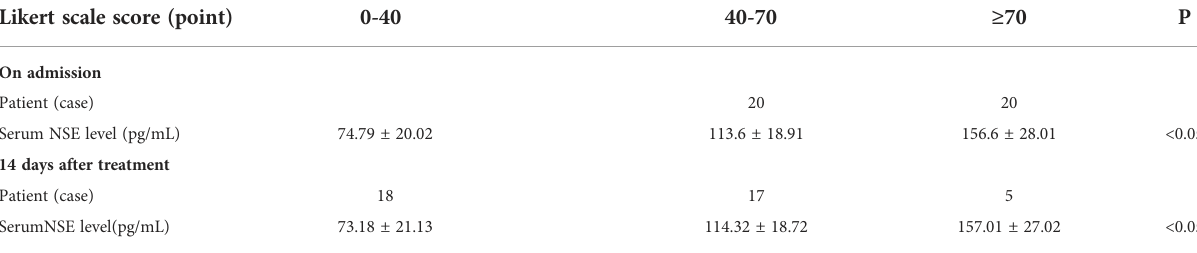
TABLE 2 Before and after 14 days of treatment, serum NSE levels in each group were correlated with the Likert Scale score. Likert scale score (point)